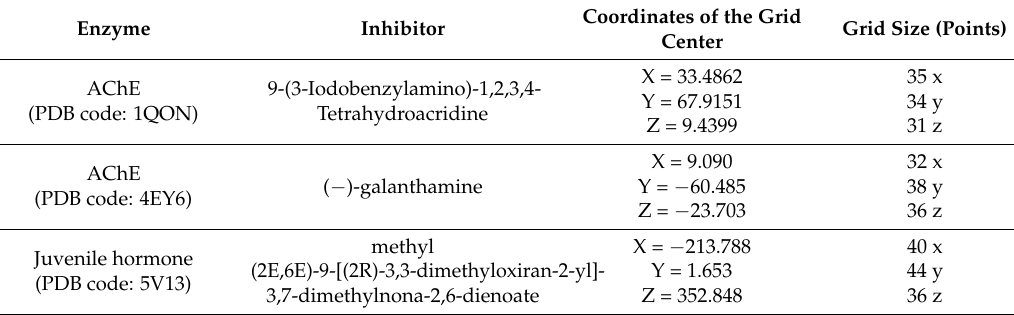
Table 5. Data from protocols used here for molecular docking